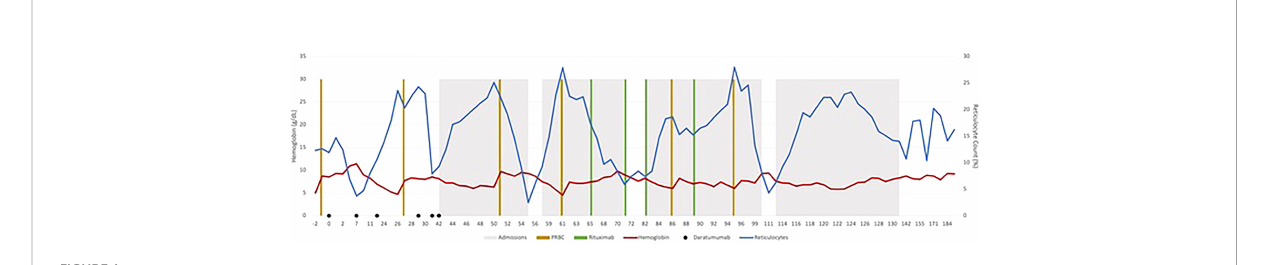
FIGURE 1 Effect of various treatments on the hemoglobin and reticulocyte count for patient